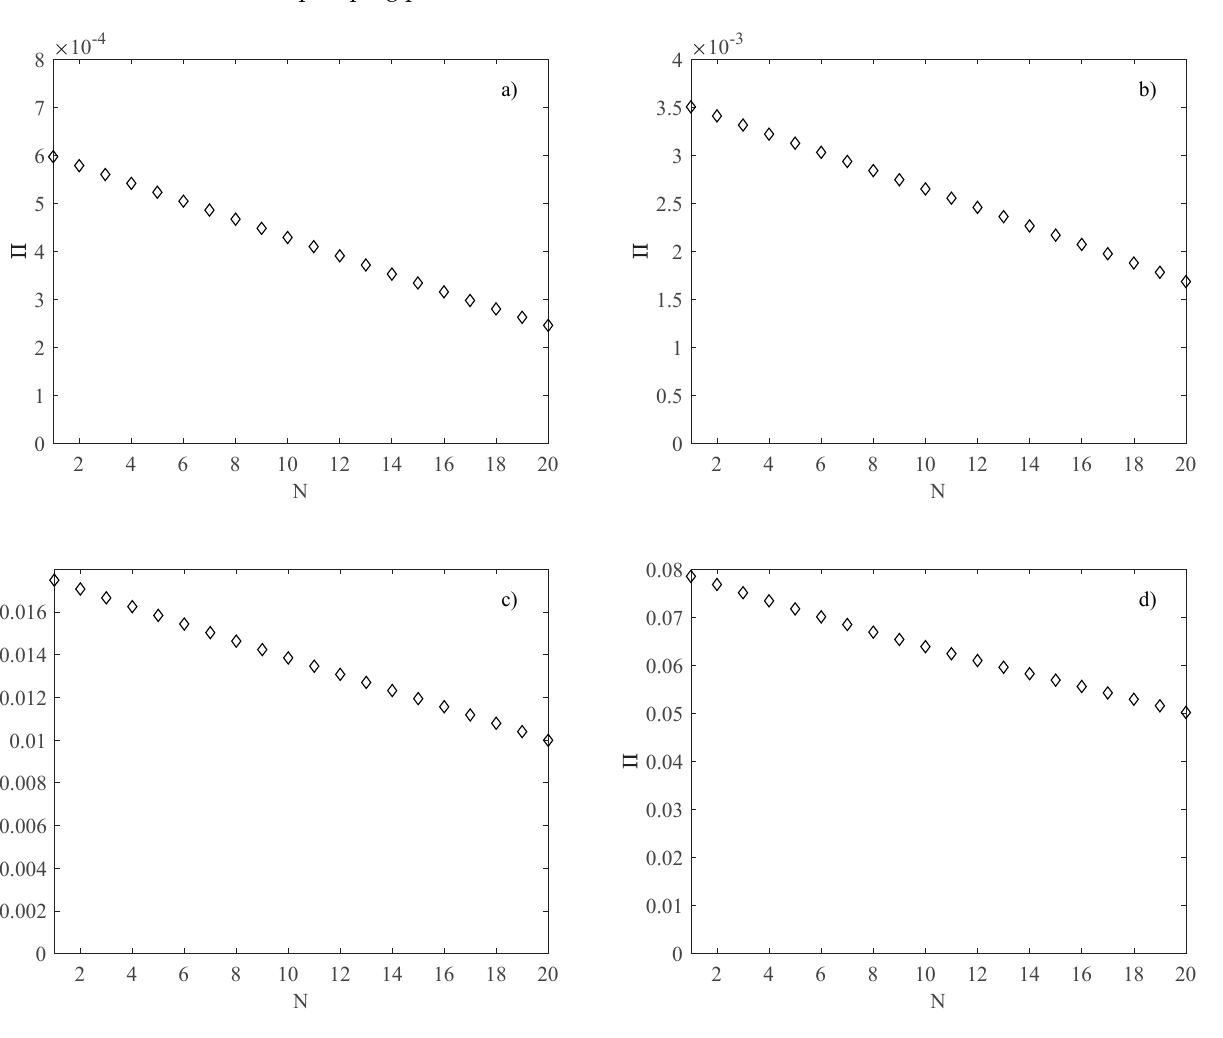
Figure 10. Pumping power (W); ( a ) B = L = 2.5 mm; ( b ) B = L = 5 mm; ( c ) B = L = 10 mm; ( d ) B = L = 20 mm.